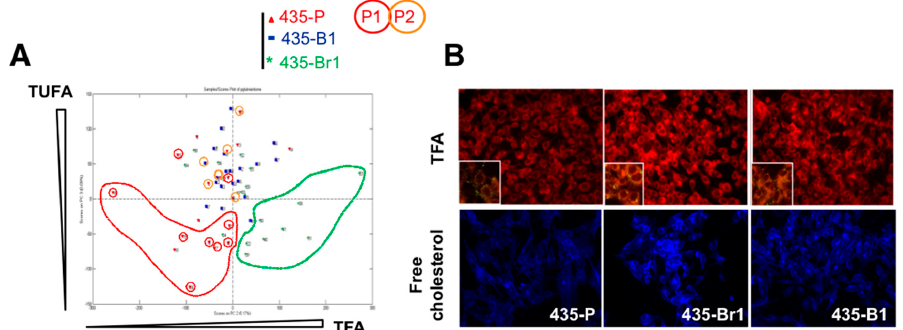
Figure 1. Brain metastatic cells present an organ-specific increase in fatty acid and